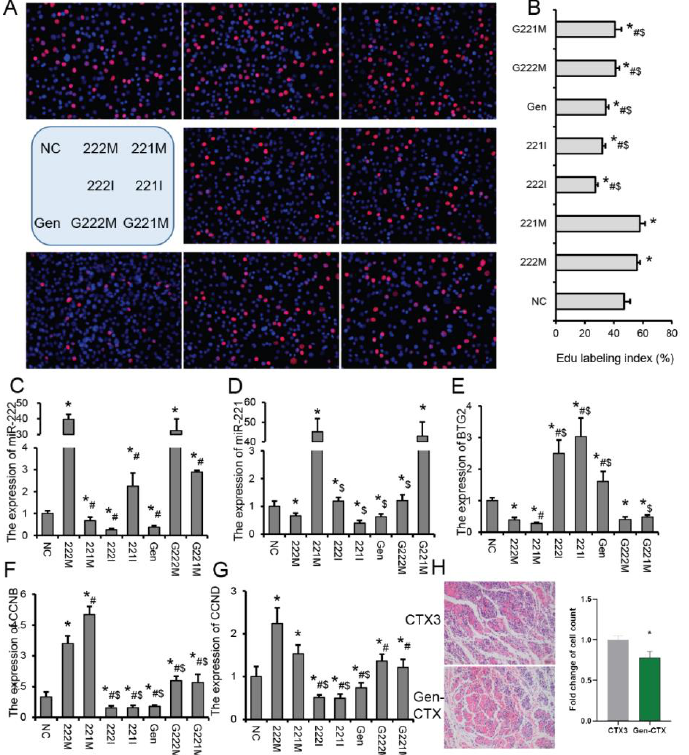
Figure 4. Effects of GEN and miR-221/222 family on myoblast proliferation. ( A , B ) EdU staining ( A ) and counting ( B ) of C2C12 myoblasts after different treatments. miR-221 mimic (221 M), miR-222 mimic (222 M), miR-221 inhibitor (221 I), miR-222 inhibitor (222 I), GEN (Gen), GEN + miR-221 mimic (G221 M) and GEN + miR-222 mimic (G222 M). ( C – G ) Expression of miR-222 ( C ), miR-221 ( D ), BTG2 ( E ), CCNB ( F ) and CCND ( G ) in C2C12 myoblasts after different treatments. ( H ) Histological sections of TA muscle at 3 days after injury from GEN-treated (Gen-CTX, start treatment 3 days before